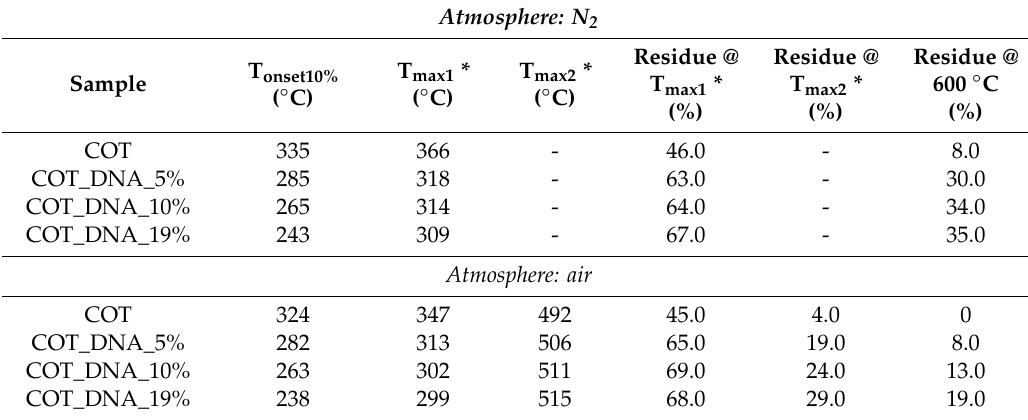
Table 8. Results from thermogravimetric analyses for untreated (COT) and DNA-treated (COT_DNA) cotton fabrics.